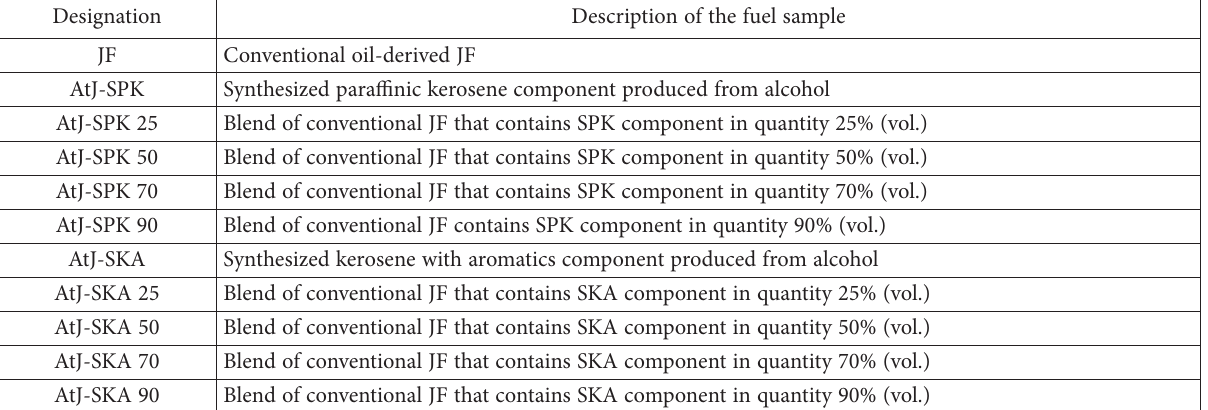
Table 2. Description of studied fuel samples (source: author